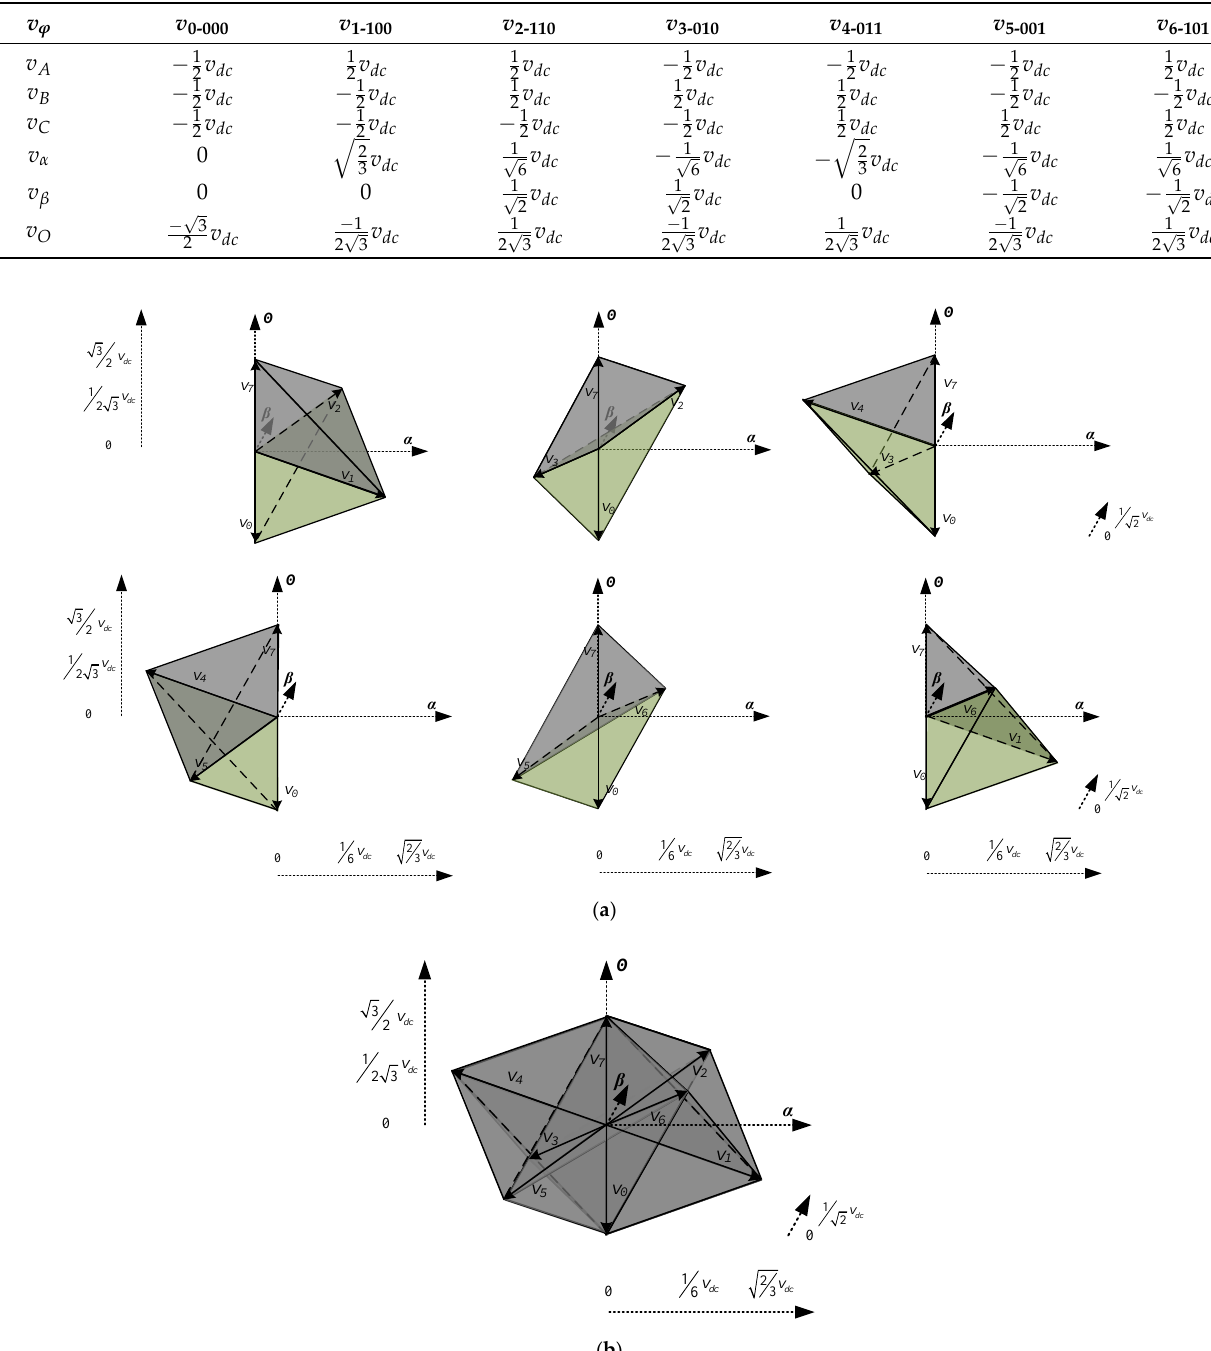
Table 2. 3D-SVM switching vectors.